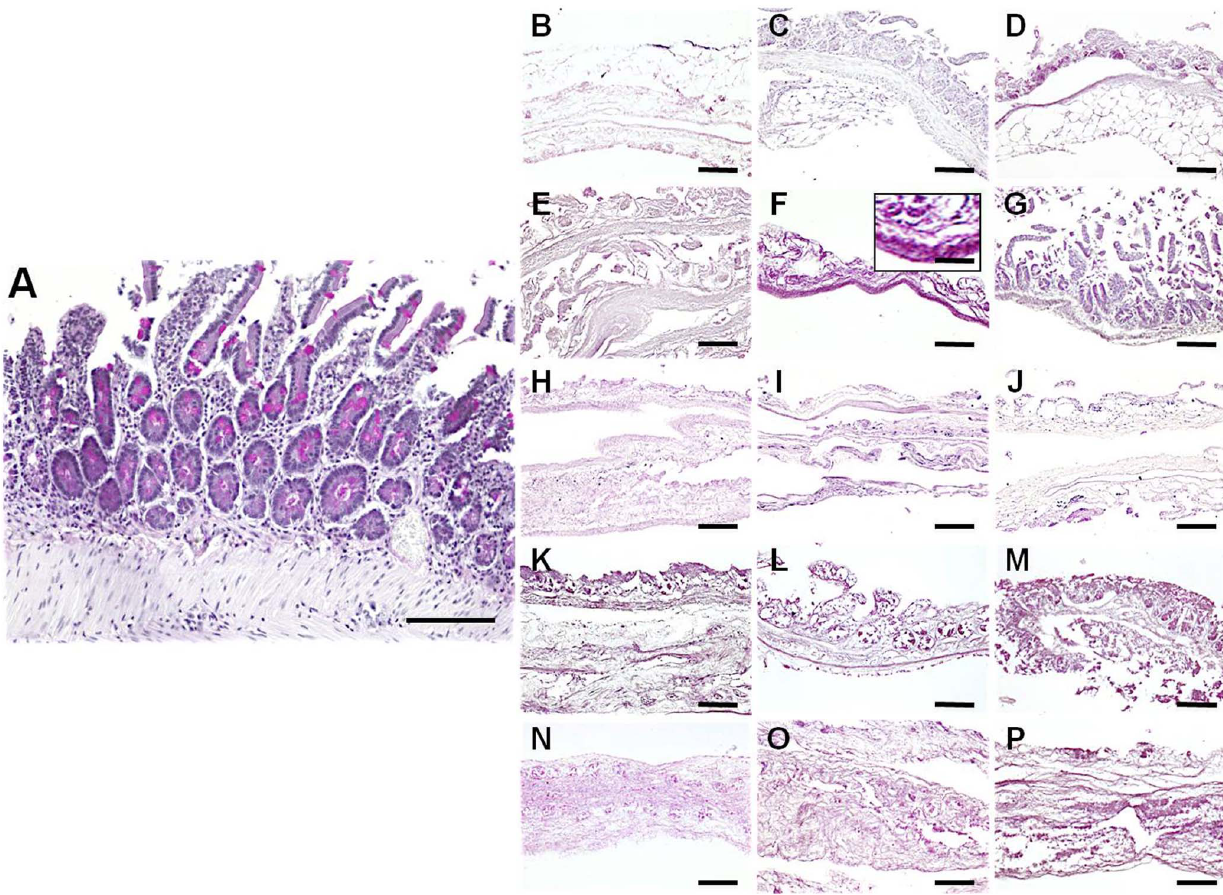
Figure 5. PAS glycoprotein staining of control SI samples (A), and tissues decellularized with 1.5 M NaCl (B), 3 M NaCl (C), 5 M NaCl (D), 0.1% SDS (E), 0.3% SDS (F), 0.6% SDS (G), 0.1% triton X-100 (H), 0.3% triton X-100 (I), 0.6% triton X-100 (J), 10 min SC (K), 20 min SC (L), 30 min SC (M), 10 min UV (N), 20 min UV (O) and 30 min UV (P). All scale bars represent 200 m m, with exception of the insert representing a higher magnification image (scale bar=800 m